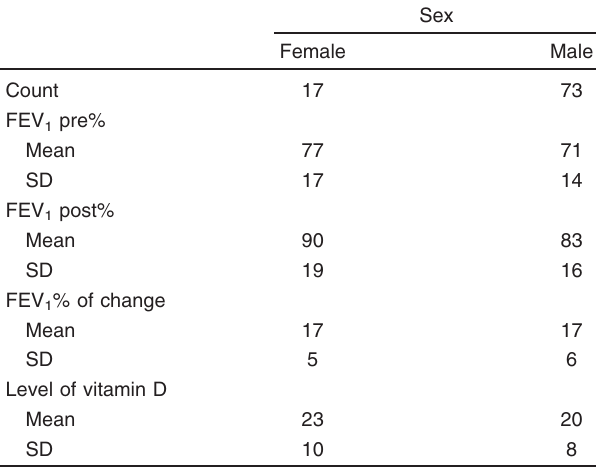
severity of asthma for the sex